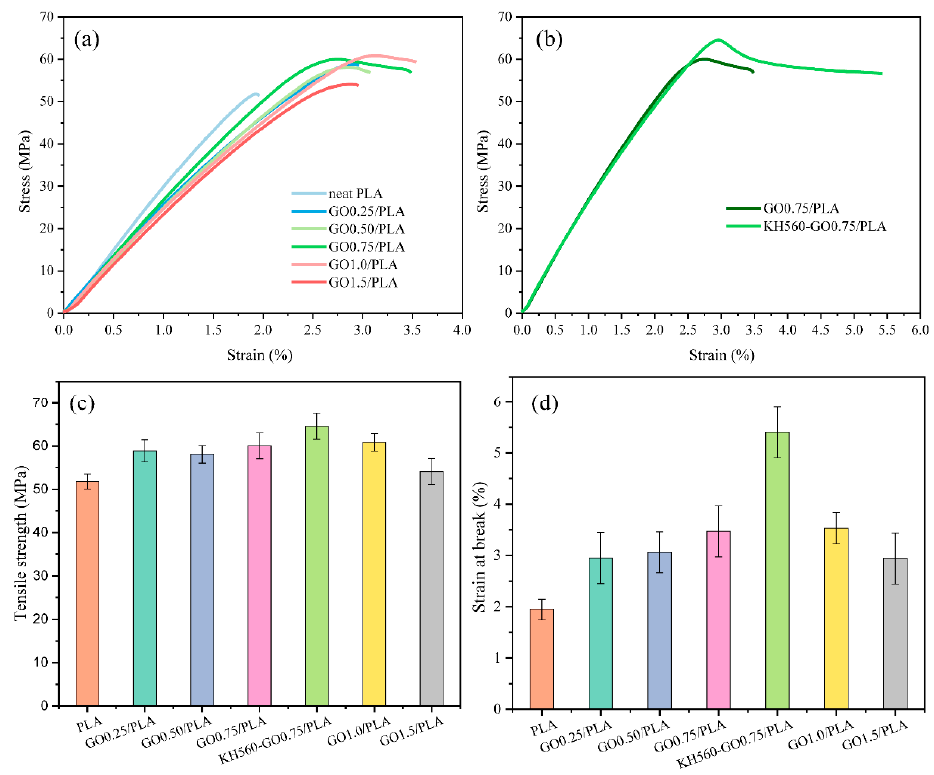
Figure 7. ( a ) stress-strain curves of GO / PLA nanocomposites, ( b ) comparison of stress-strain curves of GO0.75 / PLA and KH560-GO0.75 / PLA, ( c ) tensile strength and ( d ) elongation at break of GO / PLA and KH560-GO / PLA nanocomposites.